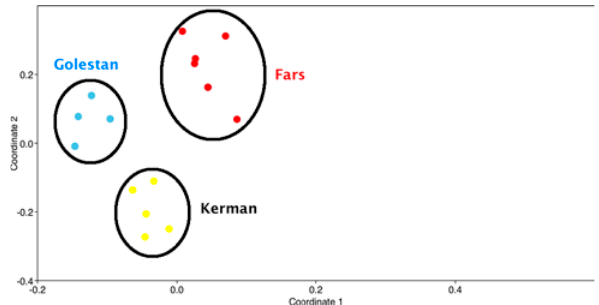
Figure 3. PCoA plot of Z. Jujube wild populations based on ISSR